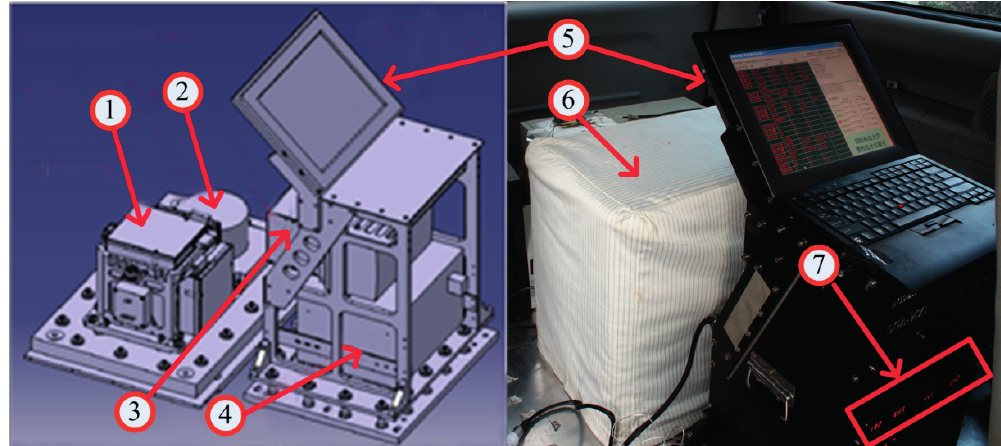
Figure 1. Structure of SGA-WZ. In the left figure, it is the 3D model of SGA-WZ without any shells; the right figure shows the working state of the